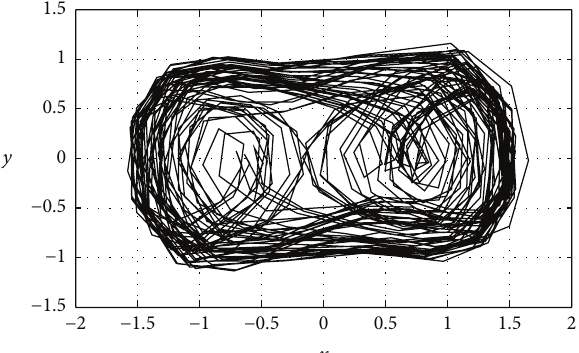
Figure7: 3DDuffing chaoticsystemphasediagraminthe 𝑥𝑜𝑦 plane